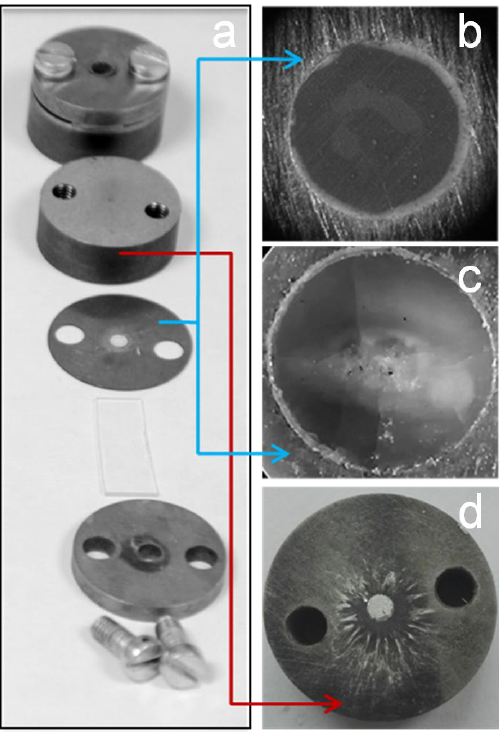
Figure 6. Photograph of the experimental setup for initiation tests ( a ), PETN-ZnO:Cu sample before ( b ) and after ( c ) laser irradiation. Aluminum foil on the steel base after the sample explosion ( d ).